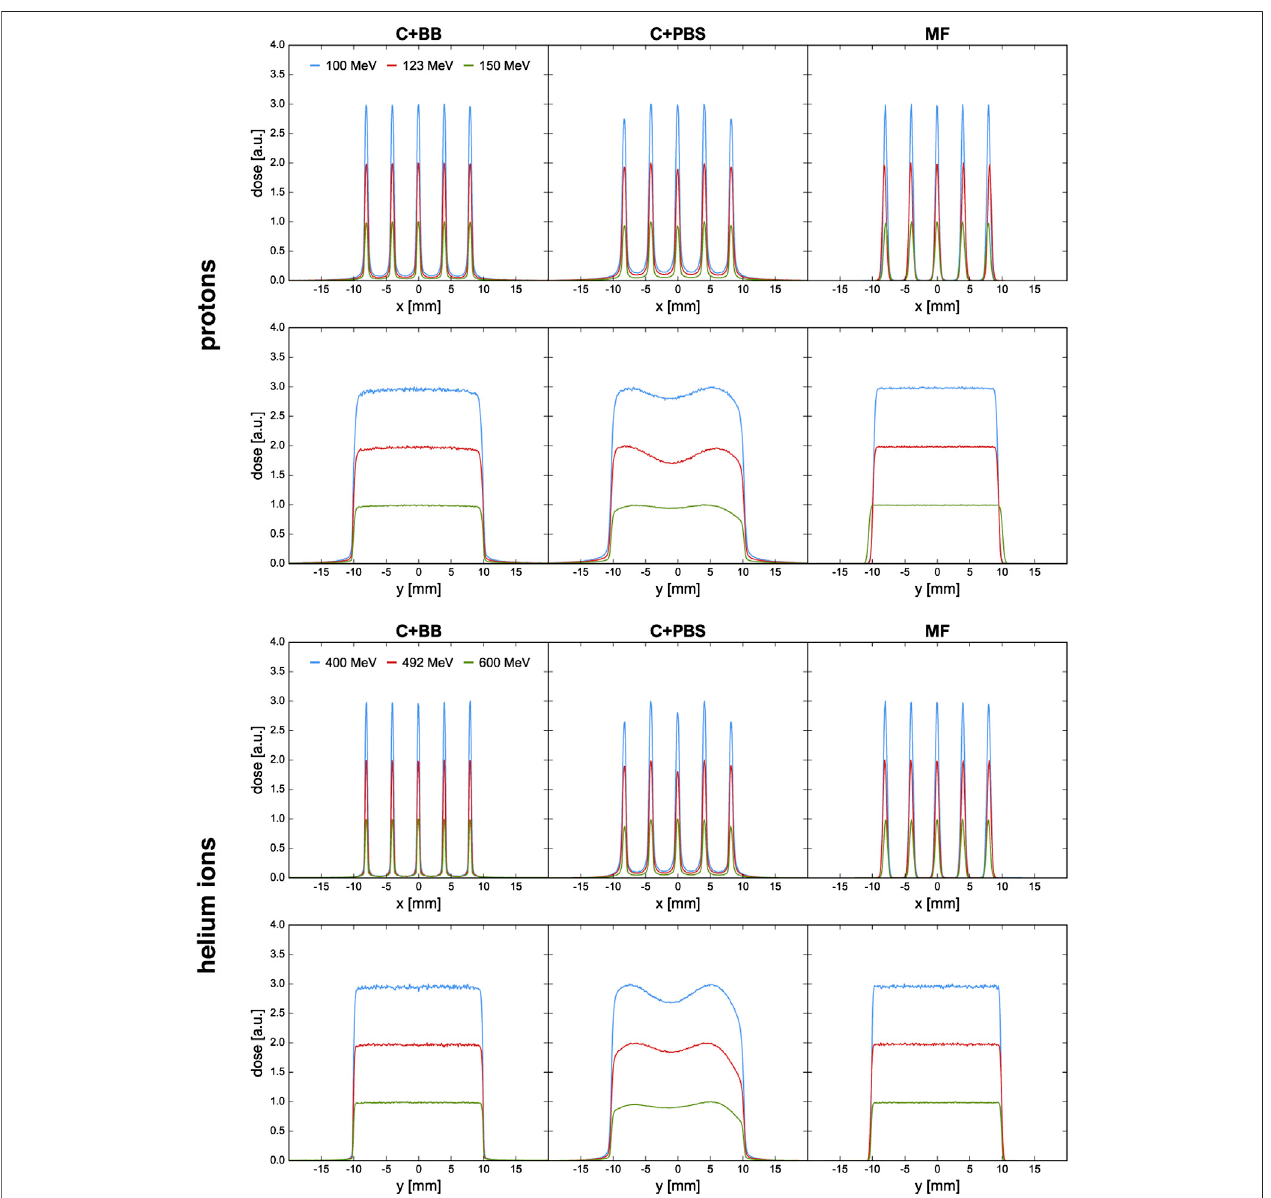
FIGURE 4 | Lateral dose profiles at the phantom entrance for proton and helium ion beams and for the different minibeam techniques (columns). The blue and red curves are arti fi cially scaled by a factor of 3 and 2, respectively, to provide better visual distinction. The fi rst and third row show the horizontal pro fi les at y (cid:2) 0 cm; the second and fourth row show the vertical pro fi les at x (cid:2) 0